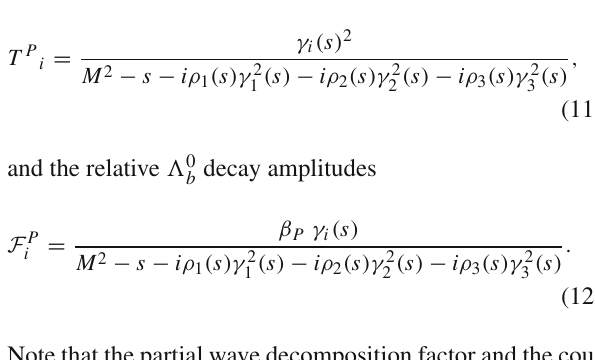
For all the fits, the masses of the resonances are given by = the PDG [36], and the central values are input as: M (cid:3) 0 b 5619 . 60 MeV, M J /(cid:2) = 3096 . 90 MeV, M p = 938 . 27 MeV, 2452 . 90 MeV. We also try to vary the input masses within the uncertainty given by the PDG and find that the fit results = 1869 . 65 MeV, change little. In Fit C we also input M ¯ D − = 2010 . 26 MeV, M = 2453 . 97 M ¯ (cid:4) ++ D ∗− c